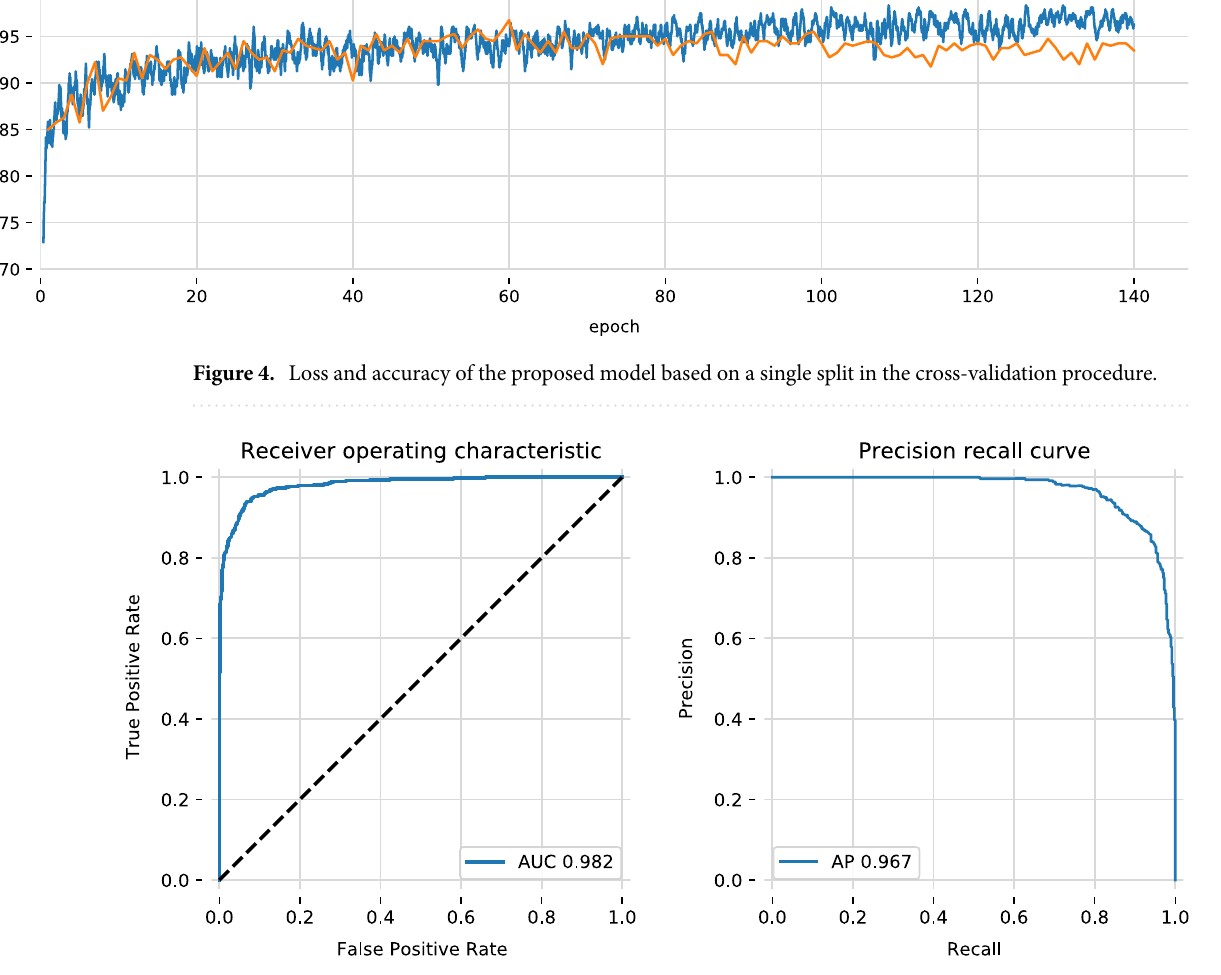
Figure 5. Both figures calculated on the results of the cross-validation procedure for the proposed model, which was built only on thermal images (last row in Table